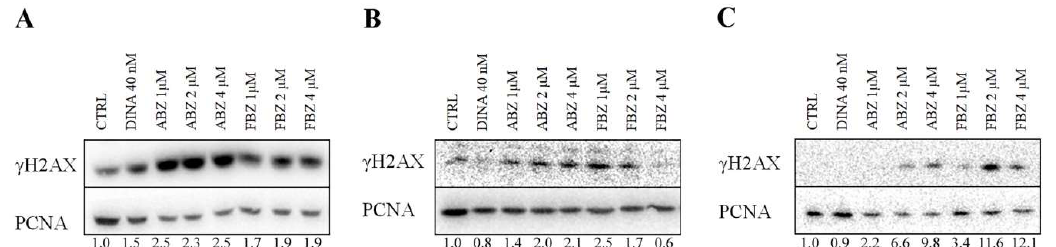
Figure 6. ABZ and FBZ caused DNA damage. WB analysis revealed increased levels of γH2AX in all ( A ) A375, ( B ) MCF7, and ( C ) HFF cells treated with ABZ and FBZ (1, 2, and 4 μM) for 24 h. Total cell lysates were separated on a 12.5% SDS gel. PCNA was used as a loading marker. Solvent (DMSO) treated cells were used as a negative control (CTRL). DINA (40 nM) that was used as a positive control affected H2AX phosphorylation only in A375 cells. Numeric values represent the ratio of band densities of the protein of interest normalized to the corresponding PCNA and the control normalized to the corresponding PCNA.